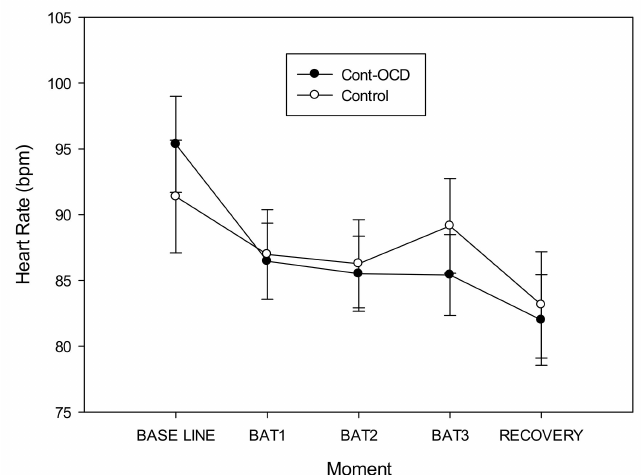
Figure 1. Heart rate mean levels and standard deviations during all the phases of the protocol (baseline, behavioral avoidance task (BAT1, BAT2, and BAT3), and recovery phases) in both groups (subclinical contamination-OCD and control